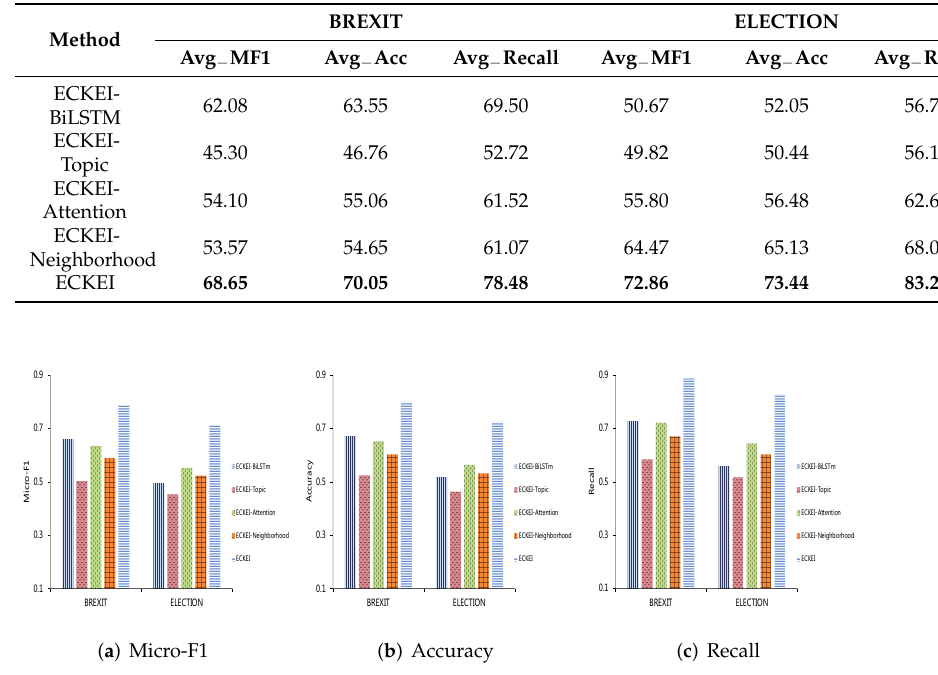
Table 5. Avg − MF1, Avg − Acc and Avg − Recall of ECKEI ablation analysis on two datasets.